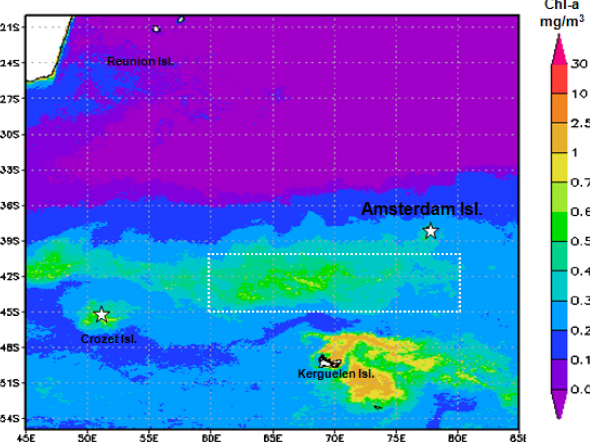
Figure 10. Chlorophyll map obtained for January (SeaWiFS data) for the Indian sector of the Austral Ocean. The white frame corre- sponds to the source region, which could contribute to the levels of marine organics at Amsterdam